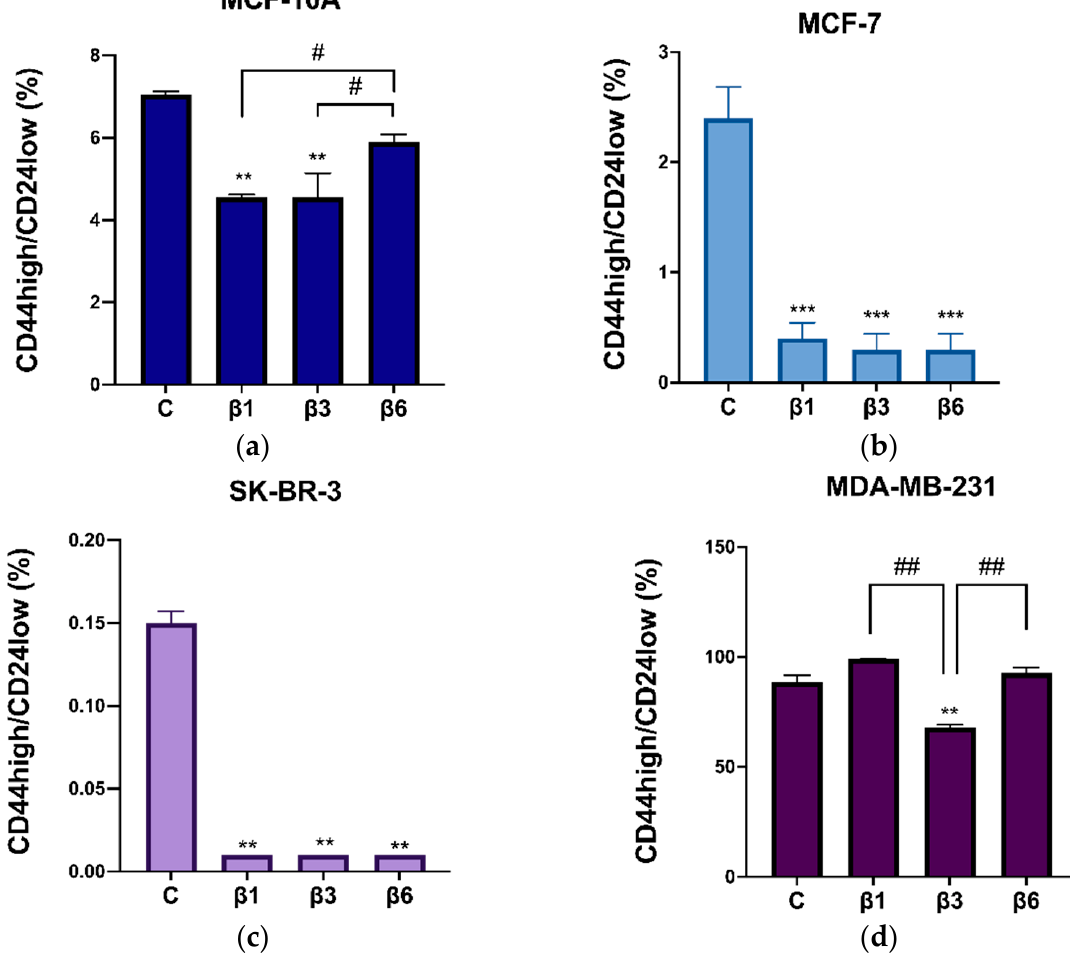
Figure 7. Expression of CD44 high/CD24 low with β 1-conglutin (2.5 ng/µL), β 3-conglutin (5 ng/µL), or β 6-conglutin (10 ng/µL) for 24 h in ( a ) MCF10-A, ( b ) MCF-7, ( c ) SK-BR-3, and ( d ) MDA-MB-321. After 24 h of ( a ) β 1, ( b ) β 3, and ( c ) β 6-conglutin treatment, cells were incubated using CD44-PE and CD24-FITC antibodies (Biolegend, San Diego, CA, USA). After 30 min of incubation in darkness and at 4 ◦ C, the samples were analyzed using a BD FACSAria IIIu flow cytometry (Becton Dickinson, BD Biosciences). ** p < 0.01, and *** p < 0.001 vs. non-treated cells, and # p < 0.05, and ## p < 0.01 vs. other